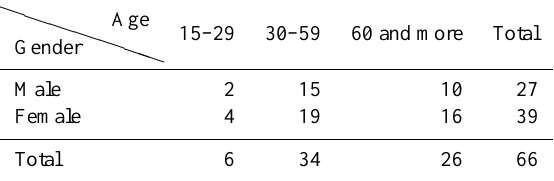
Table 1. Profile of